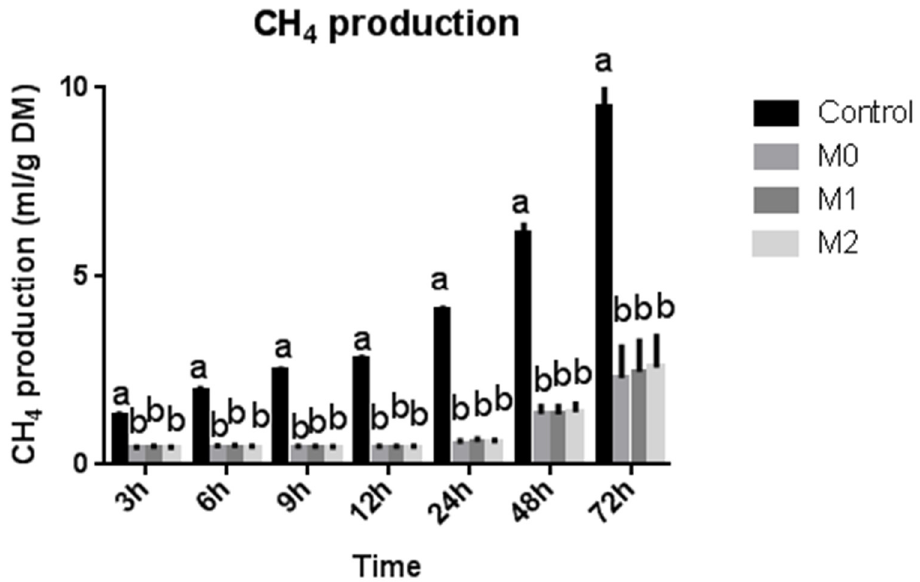
Figure 2. Total methane production at different time intervals (bars at one time interval with different letters indicate significant difference at p <